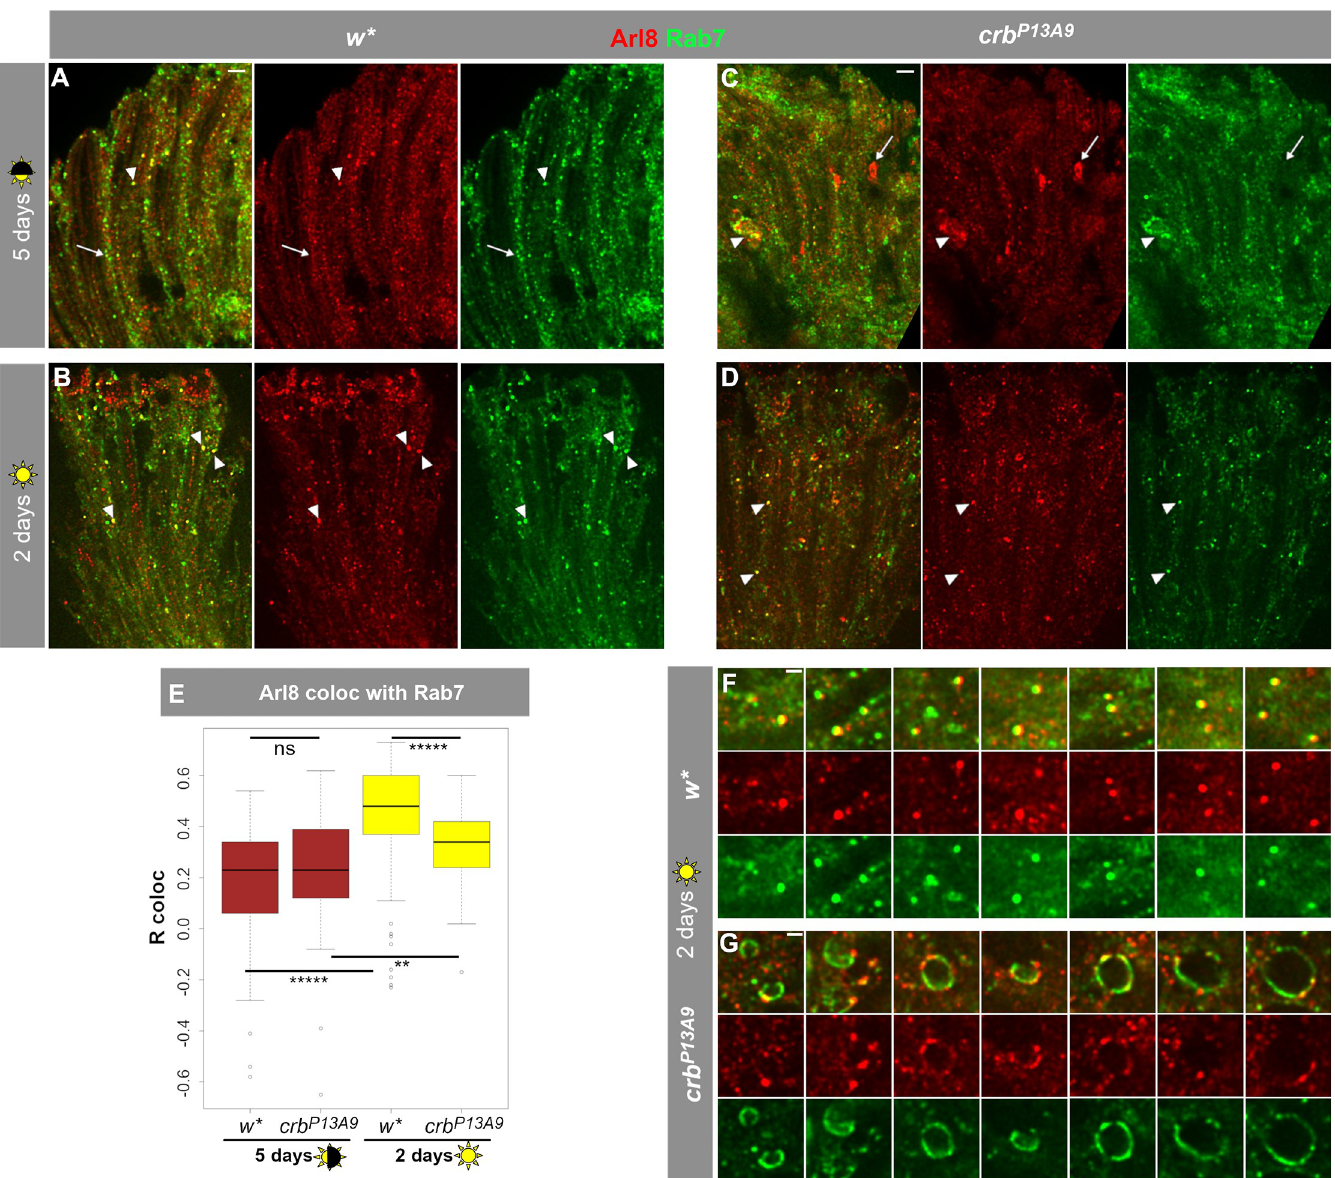
Fig 5. Exposure to constant light causes increased co-localization of Arl8 with late endolysosomal Rab7 and abnormal Rab7 compartment shapes in crb P13A9 . (A, C) w � and crb P13A9 retinas, respectively, under 5 days normal light conditions (12h light, 12h dark) show some overlap of large endogenous Rab7-carrying vesicles (green) with Arl8 (red) (arrowhead). Additionally, many normal-sized compartments in w � ( A ) and abnormal patches in crb P13A9 ( C ) are non-colocalizing (arrows), resulting in a relatively low, positive Pearson correlation coefficient (R coloc) of ~0.25 (on a scale of -1 to +1) for both genotypes over the whole retina ( E , brown boxes). (B, D) Constant light stress causes an increase in co-localization between Rab7 and Arl8 (arrowheads) in w � and crb P13A9 retinas, respectively (R coloc = ~0.5 for w � ; ~0.33 for crb P13A9 ; E ). Scale bars for A-D : 5 μ m. (E) Quantification of Rab7 and Arl8 co-localization. 5 days of normal light conditions does not reveal any significant difference in Arl8/Rab7 co-localization (brown box plots). Two days of constant light stress causes a significant increase in the Pearson correlation coefficient in w � , and a smaller but significant increase in crb P13A9 . Quantification was done on ROIs from image stacks, as described in Fig 2. For 5 days normal light, w � n = 110 images and crb P13A9 n = 118 images; for 2 days constant light, w � n = 108 images and crb P13A9 n = 105 images. ( F, G ) Enlarged images showing numerous large round lysosomal compartments in w � positive for both Arl8 and Rab7. In contrast, large, distended Rab7-positive compartments in crb P13A9 can be seen in contact with small foci of Arl8 ( G ). Scale bars: 1 μ